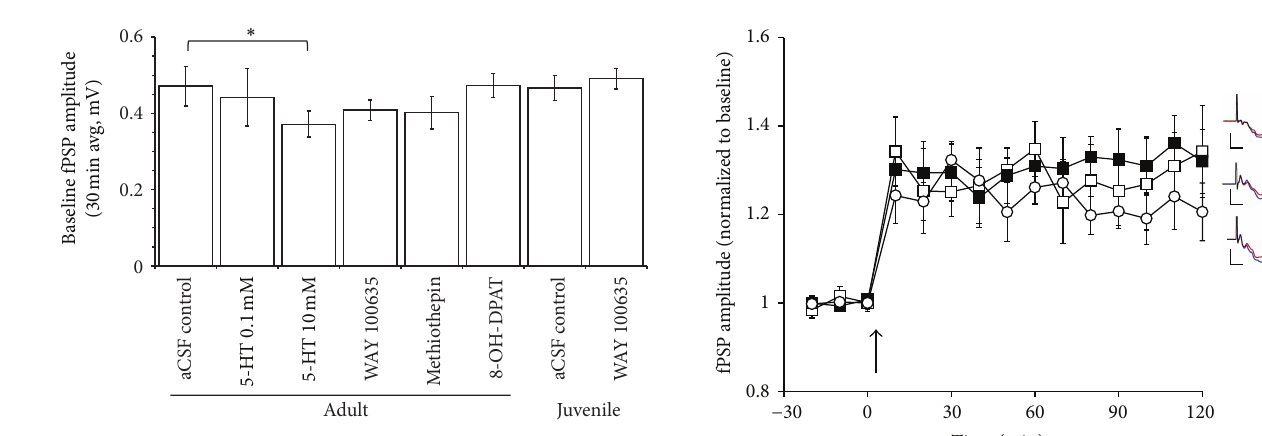
Figure 2: The effect of application (in V1 by means of reverse microdialysis; application started 20min prior to the onset of recordings) of either aCSF (adult and immature animals), 5-HT (0.1 and 10mM; adults), WAY 100635 (1mM; adults and immature), methiothepin (1mM; adults), or 8-OH-DPAT (1mM; adults) on baseline (pre-TBS delivery) amplitude of fPSP recorded in V1. Each bar represents averaged fPSP amplitudes during 30 min (i.e., 60 fPSPs) of baseline recordings. The high concentration of 5-HT (10mM) resulted in a significant ( 𝑃 < 0.05 ; 𝑡 -test) depression of fPSP amplitude compared to aCSF application. None of the other pharmacological treatments resulted in a significant change of fPSP amplitudes relative to aCSF application. ∗ indicates a significant ( 𝑃 < 0.05 , 𝑡 -test) difference between the two groups.